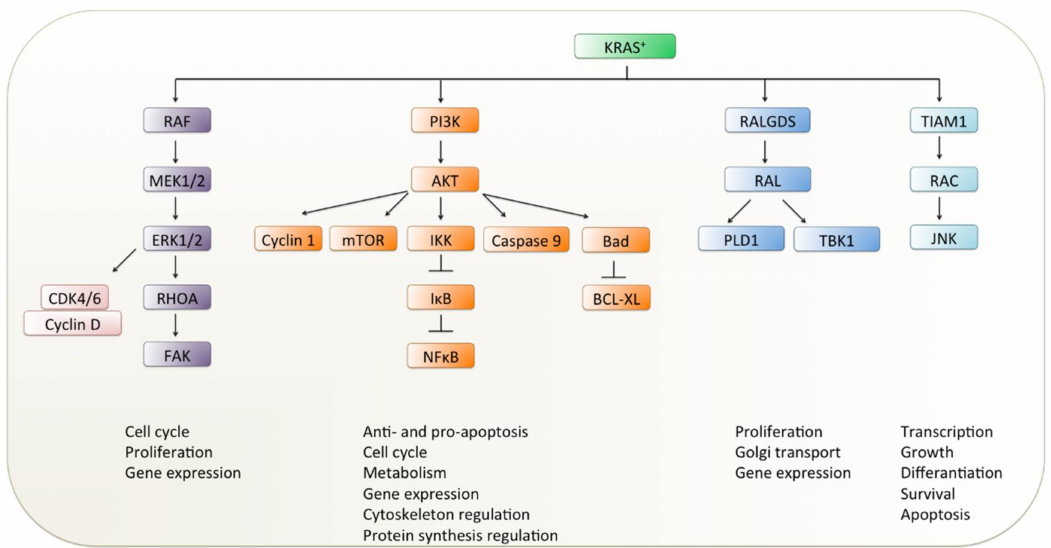
Figure 2. KRAS signaling in non-small-cell lung cancer (NSCLC). Schematic presentation of signaling pathways initiated by oncogenic KRAS aberrations is illustrated in a simplified fashion. RAF: rat fibrosarcoma; MEK: mitogen-activated protein kinase kinase; ERK: extracellular regulated kinase; PI3K: phosphoinositide 3-kinase; AKT: protein kinase B; mTOR: mechanistic target of rapamycin kinase; RALGDS: Ral guanine nucleotide dissociation stimulator; KRAS: Kirsten rat sarcoma viral oncogene homolog; CDK4 / 6: cyclin-dependent kinase 4 / 6; RHOA: Ras homolog family member; FAK: focal adhesion kinase; IKK: IkappaB kinase; I κ B: nuclear factor of kappa light polypeptide gene enhancer in B-cells inhibitor; NF- κ B: nuclear factor ‘kappa-light-chain-enhancer’ of activated B-cells; Bad: BCL2-associated agonist of cell death; BCL-XL: B-cell lymphoma-extra large; RAL: Ras-like protein; PLD1: phospholipase D1; TBK1: TANK binding kinase 1; TIAM1: T lymphoma invasion and metastasis-inducing protein 1; RAC: Ras-related C3 botulinum toxin substrate 1; JNK: c-Jun N-terminal